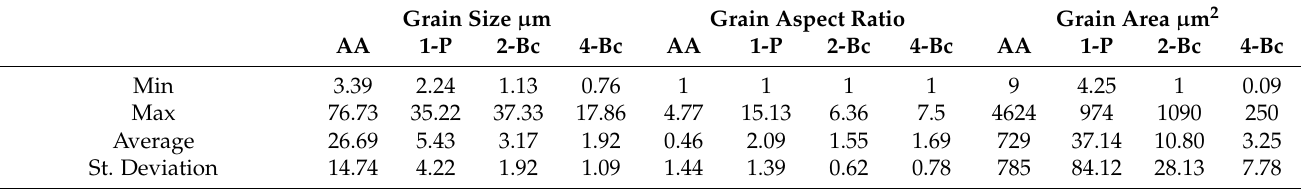
Figure 6. Relative frequency of the ( a ) LAGBs and ( b ) HAGBs of the ZK30 alloy AA and ECAPed billets. Table 1. Grain size, aspect ratio, and grain area data of AA and the ECAPed ZK30 billets.